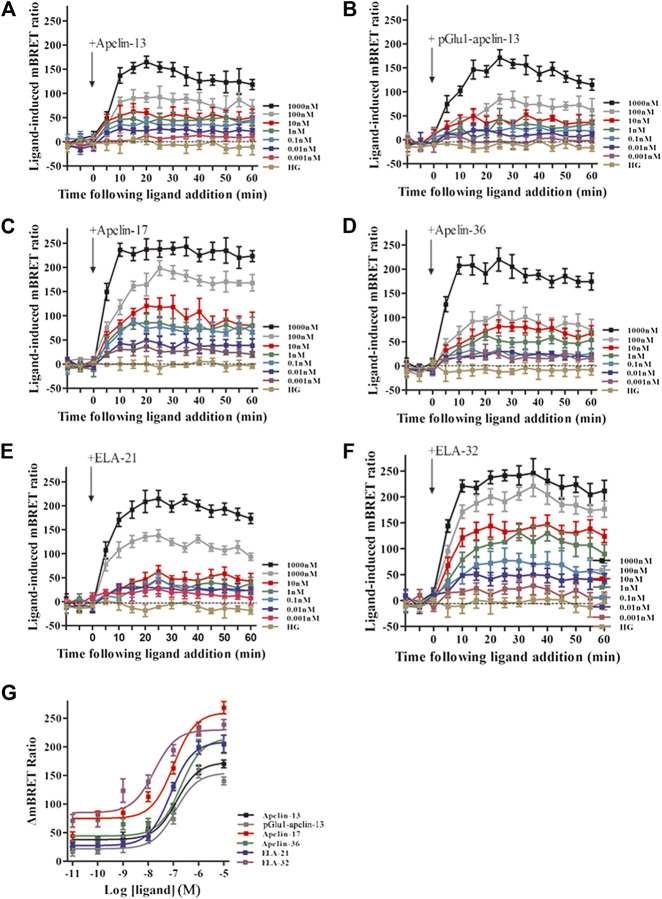
The time-response curve (A–F) and dose-response curve (G) of interactions between APJ and β-arrestin2 induced by the six agonists in different concentrations, obtained from real-time dynamic BRET determinations. p < 0.05 was considered as statistically significant. Control group (HG, Cells were stimulated with high glucose). In HEK293 cells expressing APJ and β-arrestin 2, the dose-response curves of the six peptides at 20 min were observed. The data represent means ± SEM of four independent experiments. Statistical analysis (Supplementary Table S6).